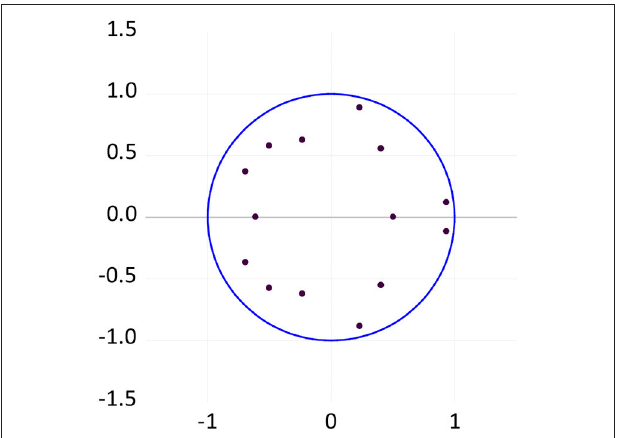
FIGURE 4 | Inverse roots of AR characteristic polynomial.